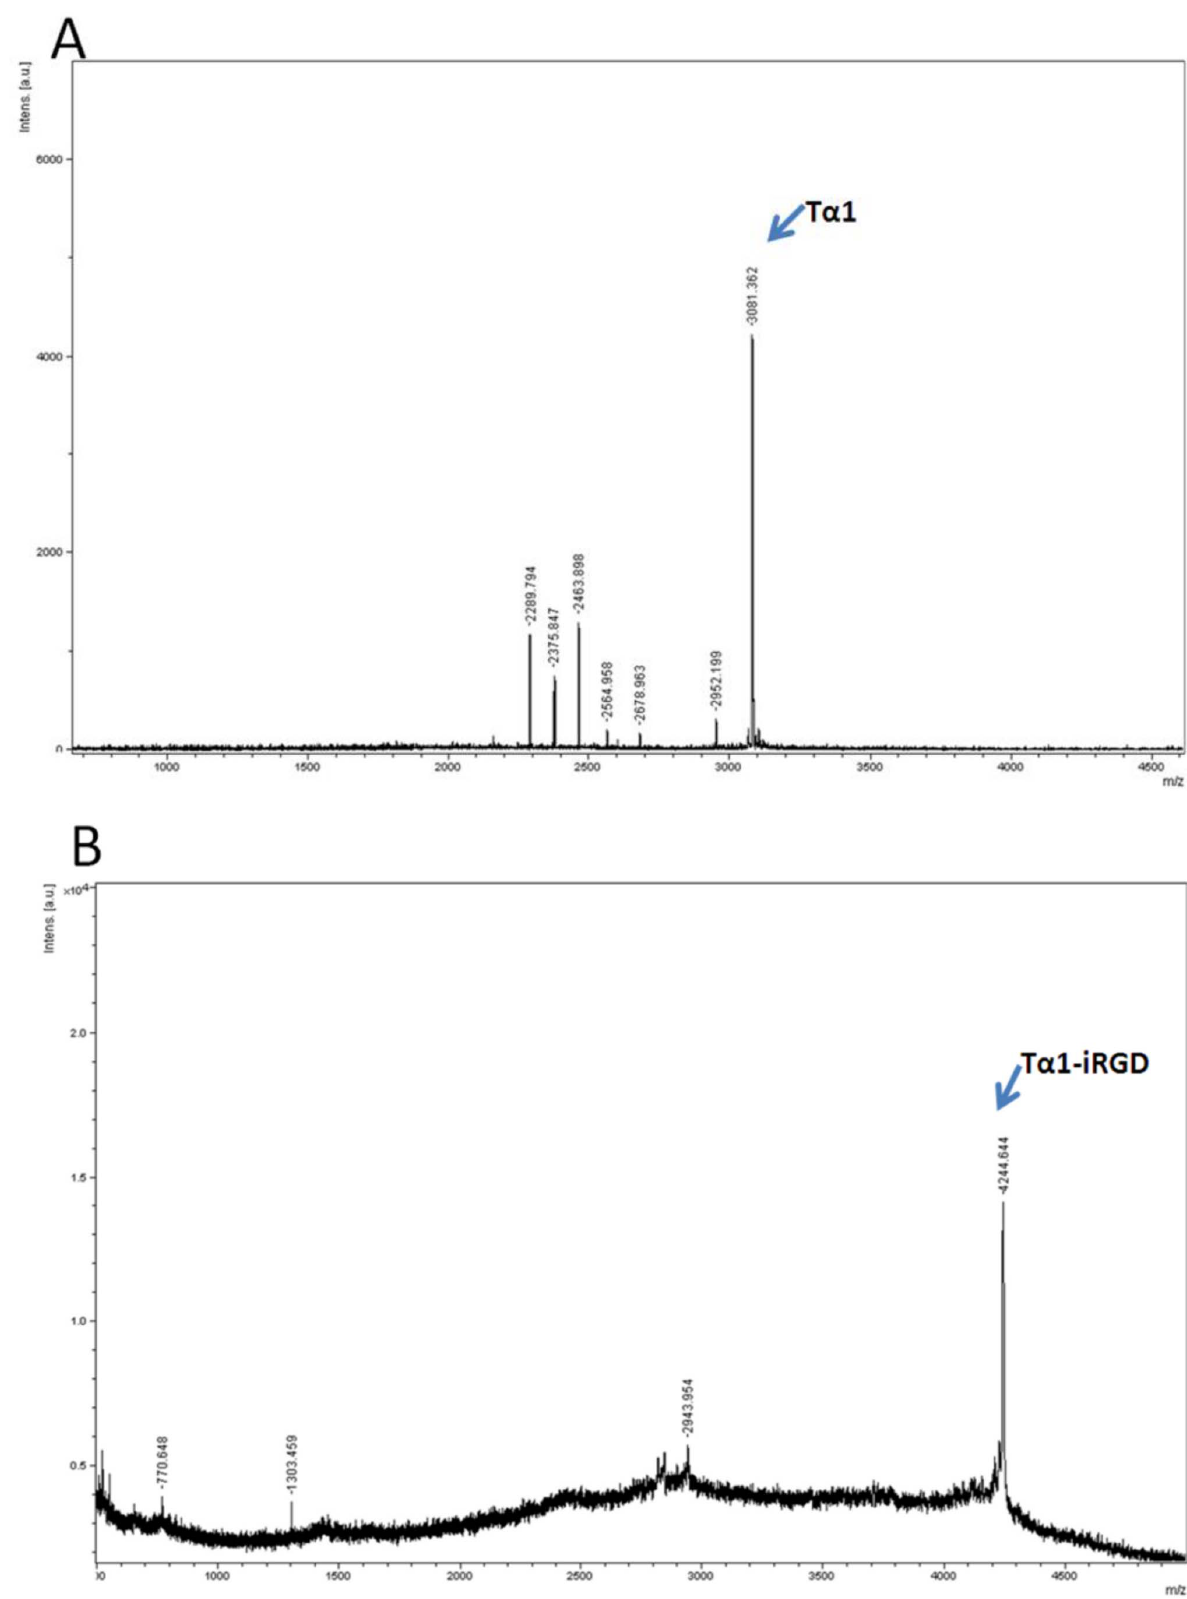
Figure 2. Mass spectroscopy result of recombinant T a 1 or T a 1-iRGD. A. T a 1; B. T a 1-iRGD.